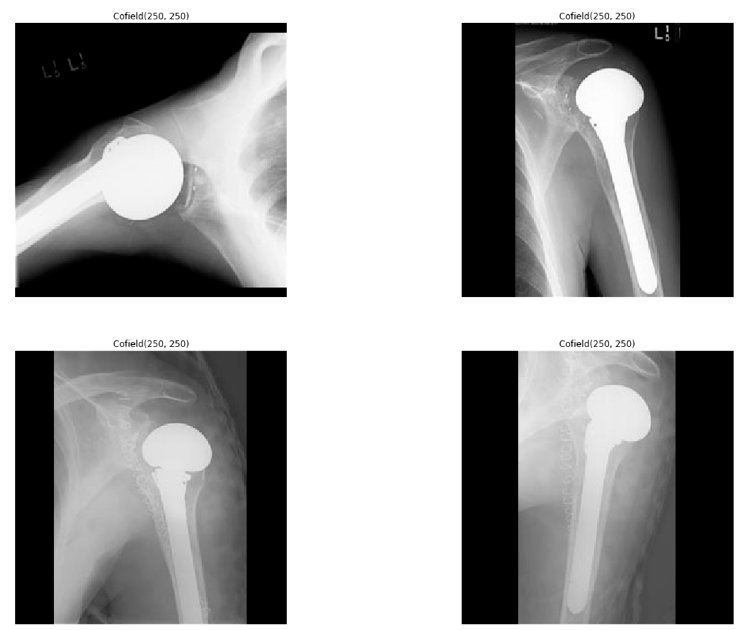
Figure 2. Sample shoulder implant X-ray images.